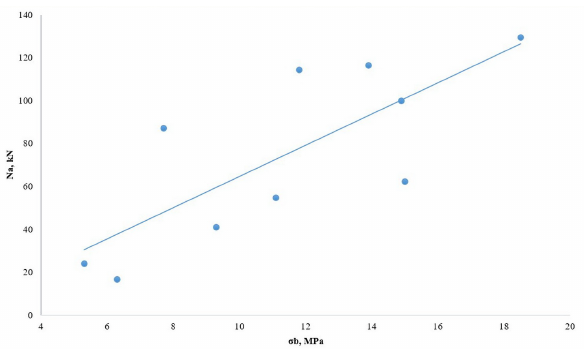
Figure 2: Dependence N a from σ b